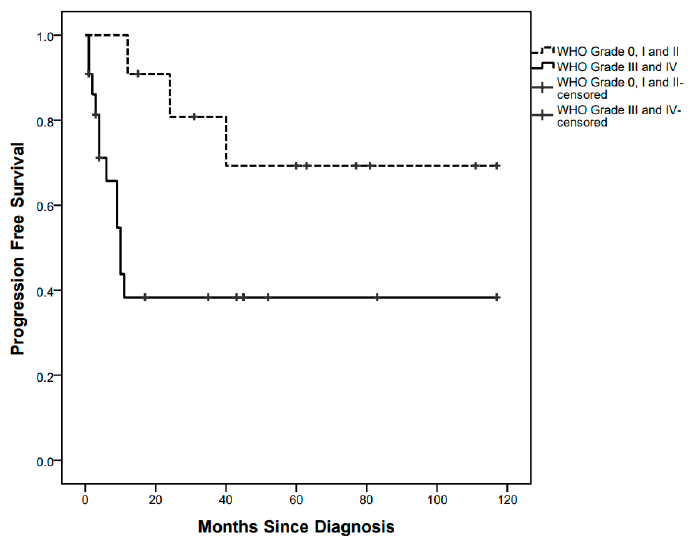
Figure 2. Progression-Free Survival curves by low-grade and high-grade pathology. High-grade pathology was indeed the only predictor of progression in the univariate Cox Regression analysis (HR 3.7, 95% CI 1.1–13.31, p = 0.045), while the other explored variables were not found statistically significant (ICHT p = 0.411; age at diagnosis p = 0.115; GTR p =